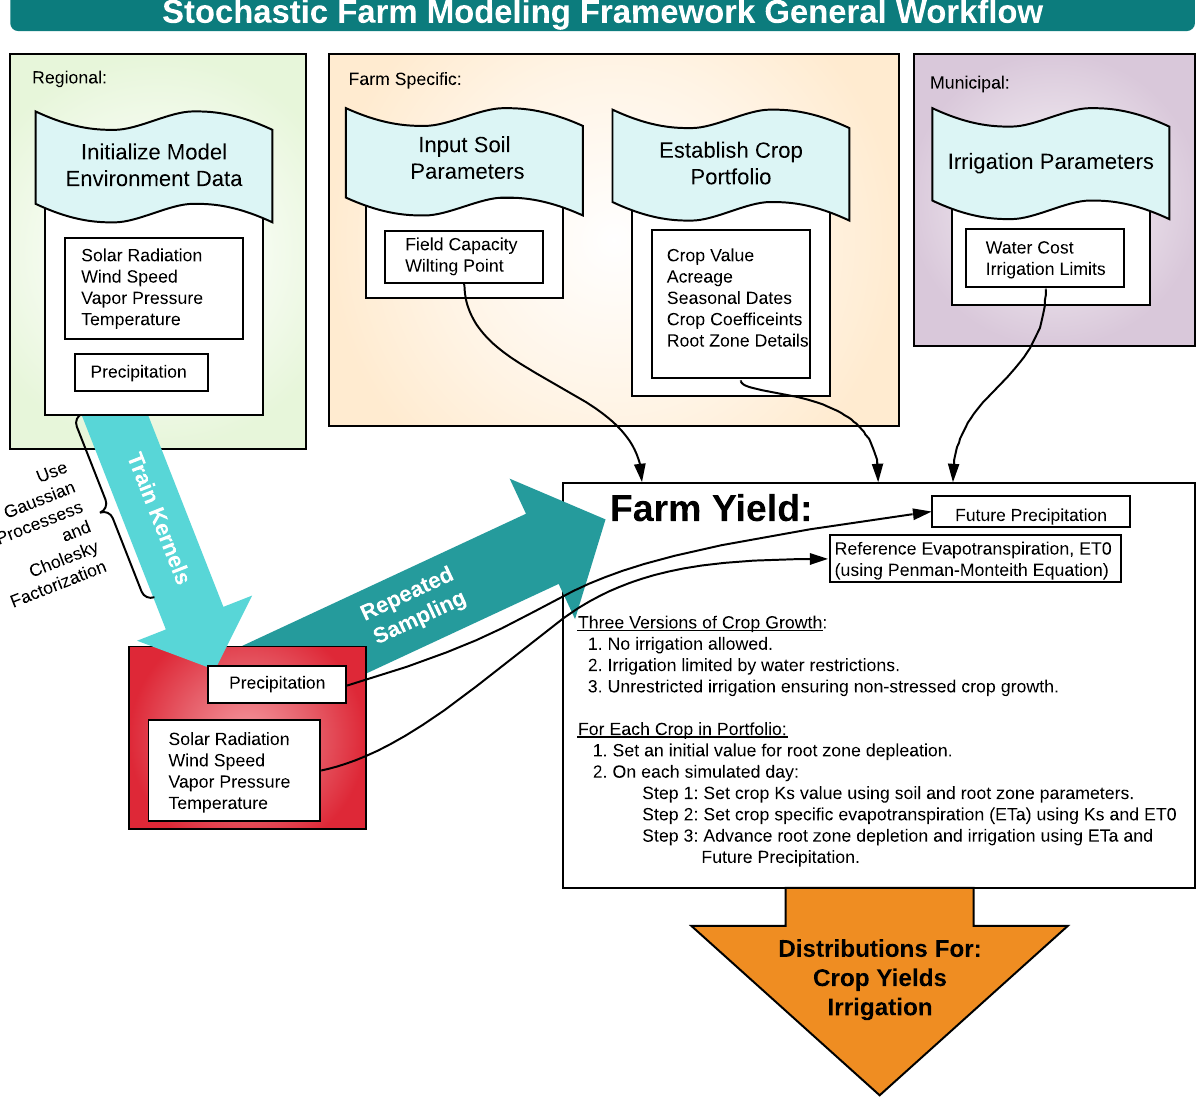
Figure 3. Overview of the stochastic modeling workflow. Note that repeated sampling of trained environment-specific parameters leads to distributions for a modeled crops yield and paired irrigation use in three distinct situations: no irrigation, restricted irrigation, and unrestricted